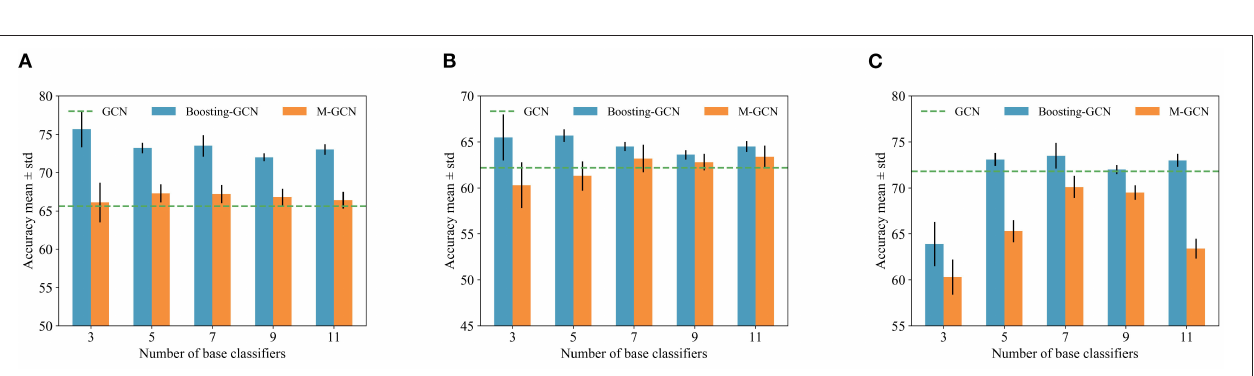
FIGURE 4 | Classification accuracy for the Cora dataset. The features are removed randomly, and the result of 10 runs is averaged. A different random seed is used for every run (i.e., removing different features from each node), but the same 10 random seeds are used across models.